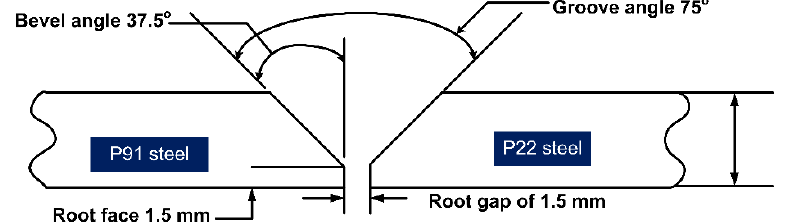
Figure 2. Conventional V-groove geometry. Table 2. Welding process parameters.